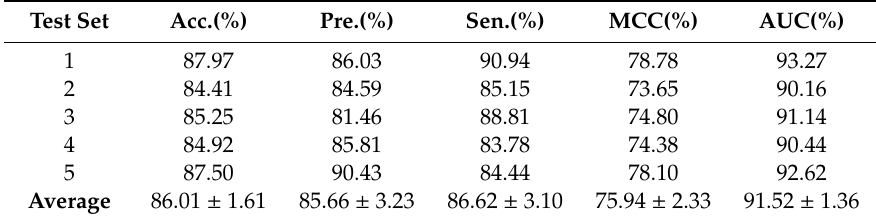
Table 2. The five-fold cross-validation results achieved on ion channel dataset by using the proposed model.